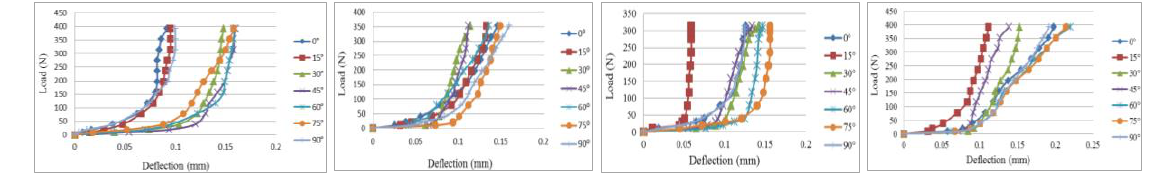
Fig 8a: Load v/s Deflection curves for 4- grooves ISSFD rings